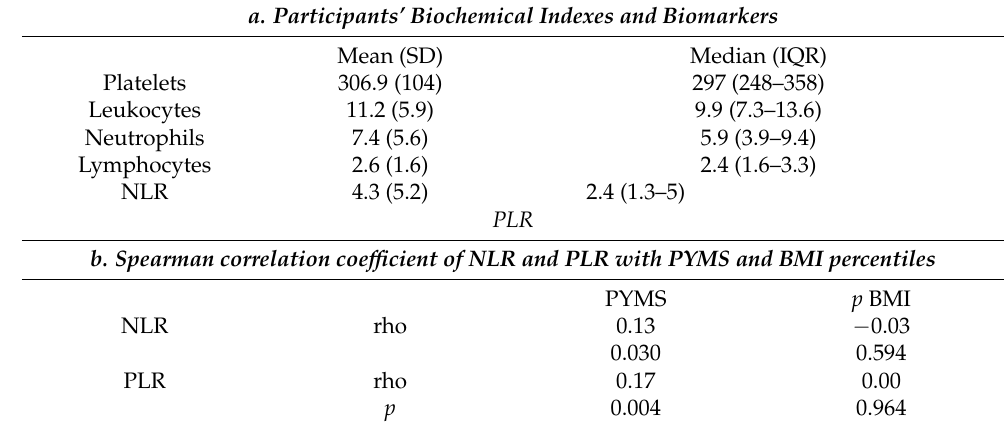
Table 2. (a) Participants’ biochemical indexes and biomarkers, (b) Spearman correlation coefficient of NLR and PLR with PYMS and BMI